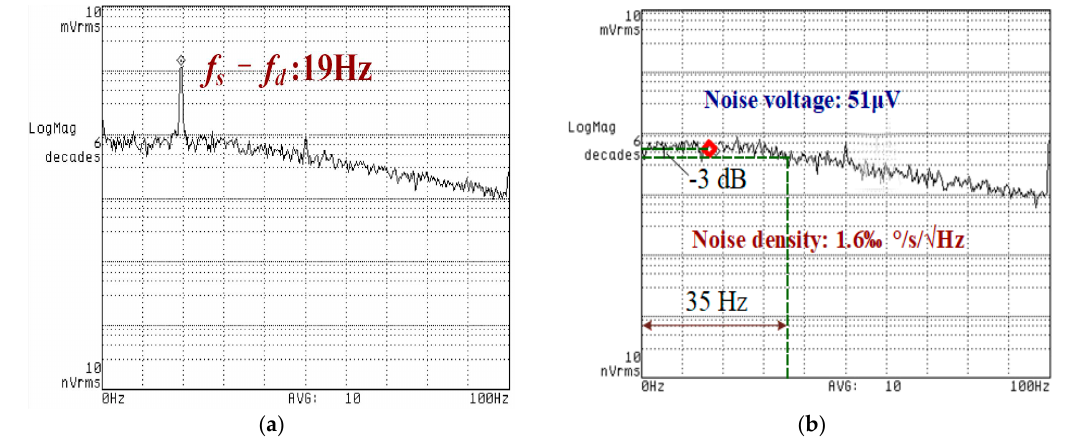
Figure 10. ( a ) Low frequency information generated by external disturbance; ( b ) zero-rate output after oscillation suppression.